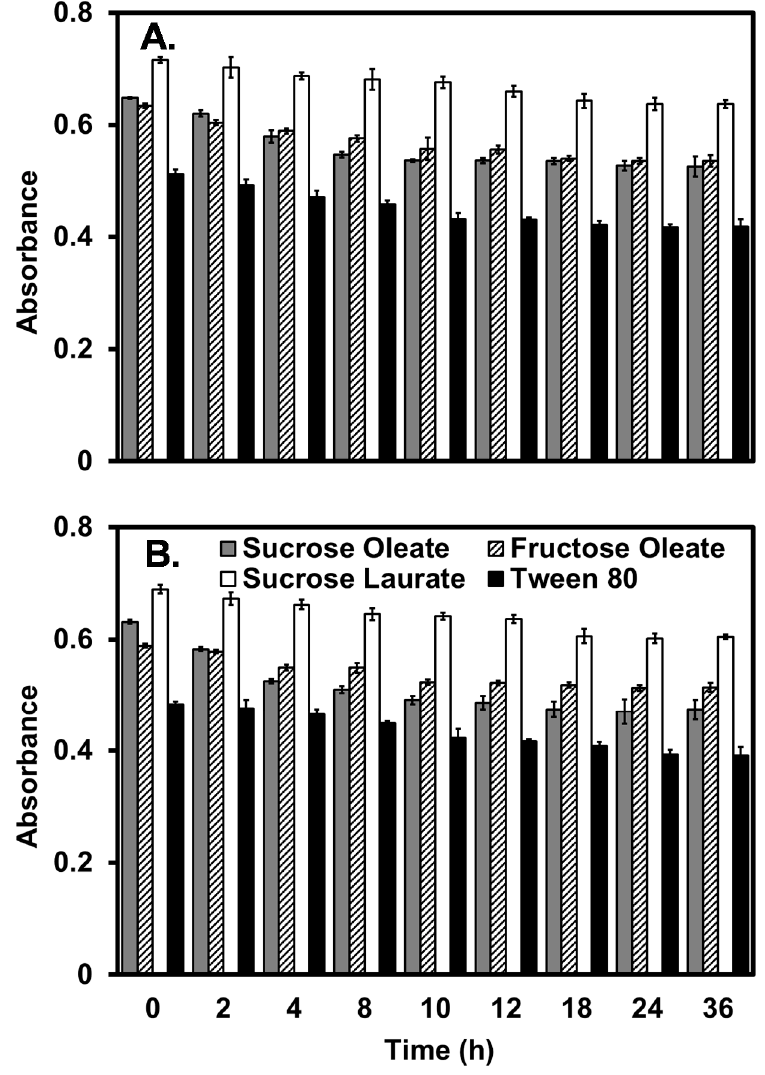
Figure 3. Emulsification of ( A ) hexadecane and ( B ) dodecane by sugar esters: sucrose oleate (gray); fructose oleate (slash); sucrose laurate (white); and Tween ® 80 (black; a control) at 22 °C, evaluated over a 36 h period. Aqueous solutions of 2 g/L sugar ester were vigorously mixed with oil, then allowed to settle in the absence of stirring for 20 min. The turbidity of the sample was measured via absorbance at 600 nm.